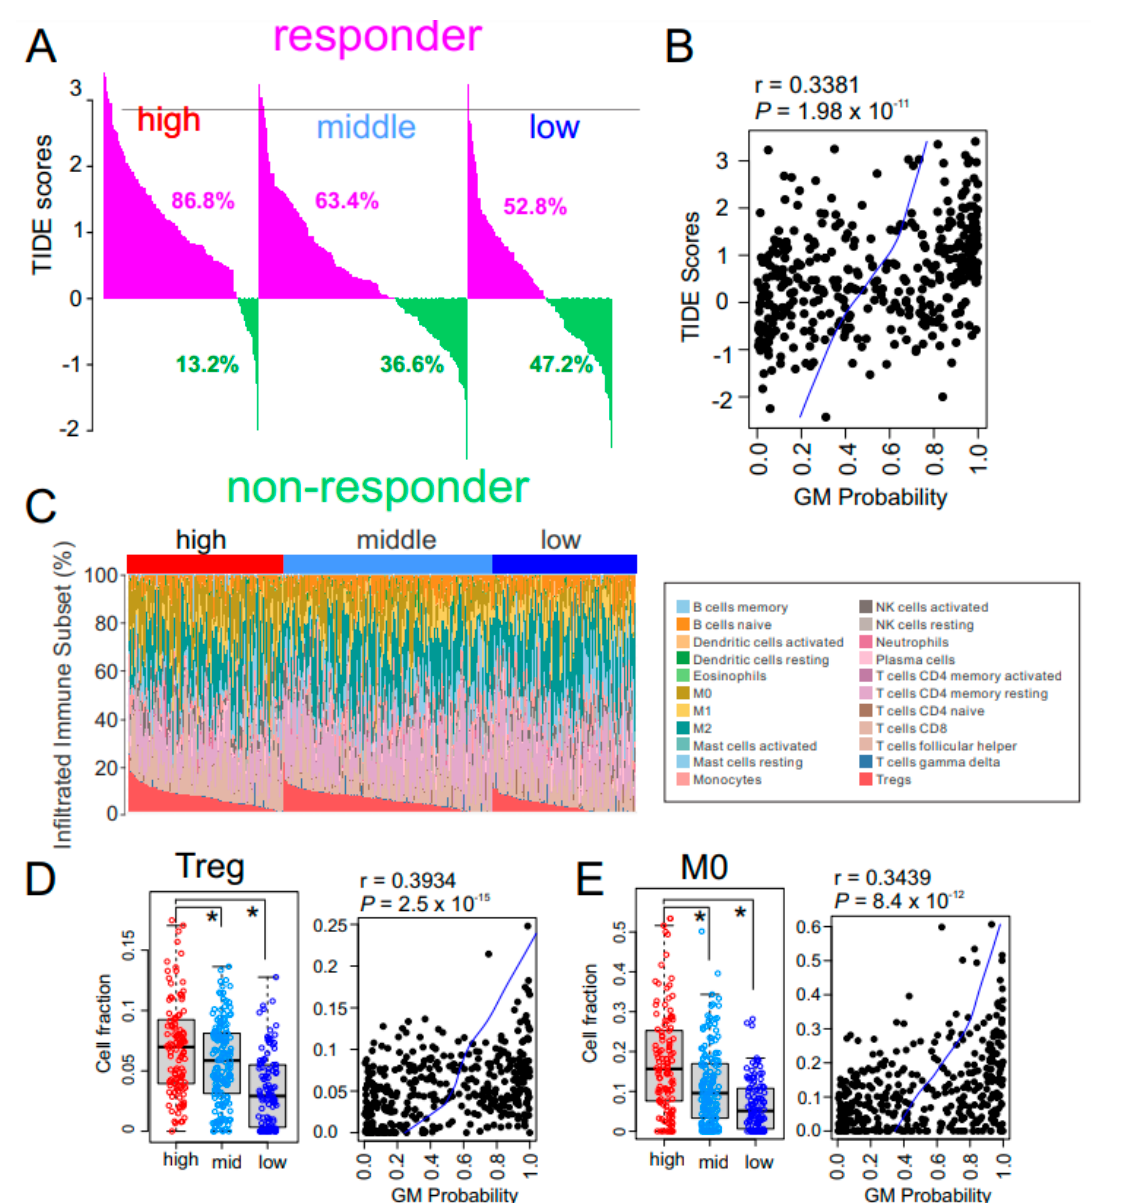
Figure 5. Immune characteristics of the glycolysis metabolic (GM) subtypes. ( A ) Waterfall plots for the response rates to immunotherapy predicted by the tumor immune dysfunction and exclusion (TIDE) algorithm in The Cancer Genome Atlas Liver Hepatocellular Carcinoma (TCGA-LIHC) cohort ( n = 371). Numbers below waterfall plots represent the fraction of responders in the patients with each GM subtype. ( B ) Scatter plot for the correlation between TIDE score and GM probability in the TCGA cohort ( n = 371). Blue line indicates locally weighted scatterplot smoothing (lowess) regression. ( C ) The pattern of infiltrations of 22 immune subsets according to GM subtype from fetal liver signatures predicted by the CIBERSORT algorithm in the TCGA cohort. ( D , E ) Box and scatter plots of fraction of regulatory T cells (Tregs) ( D ) and M0 macrophages ( E ) in GM subtypes. Relative fraction of each immune-subset was normalized by mean and standard deviation across the samples. In the scatter plots, blue line indicates locally weighted scatterplot smoothing (lowess) regression. In the box plots, the boundary of the box indicates the 25th to 75th percentile, and the black line within the box marks the mean. Whiskers above and below the box indicate the 10th and 90th percentiles. Each circle represents the fraction of indicated immune cells in each tumor. * p < 0.001 by Student t